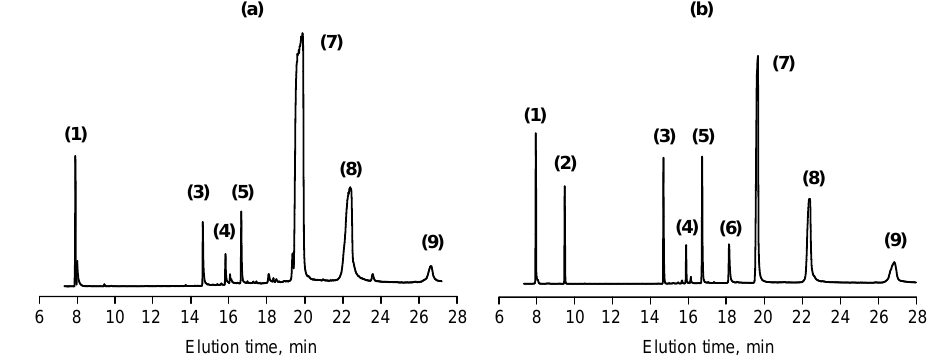
Figure 6. Chromatograms of organic epoxides obtained by schemes A ( a ) and B ( b ).